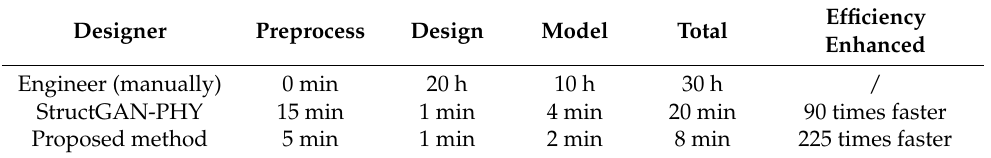
Figure 12. Evaluation results of the typical case: ( a ) planar layout consistency; ( b ) vertical load transferability; ( c ) physical performance. Table 1. Comparison between designs of data-driven and physics-enhanced models. Table 2. Comparison of design efficiency between different